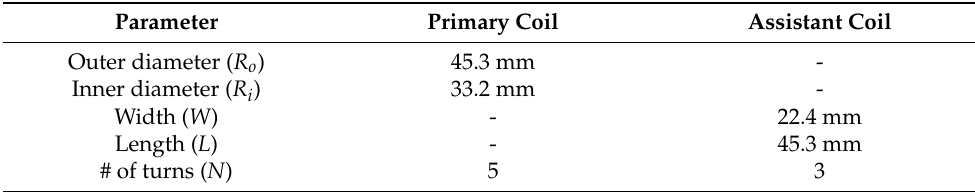
Table 1. Final design parameters.